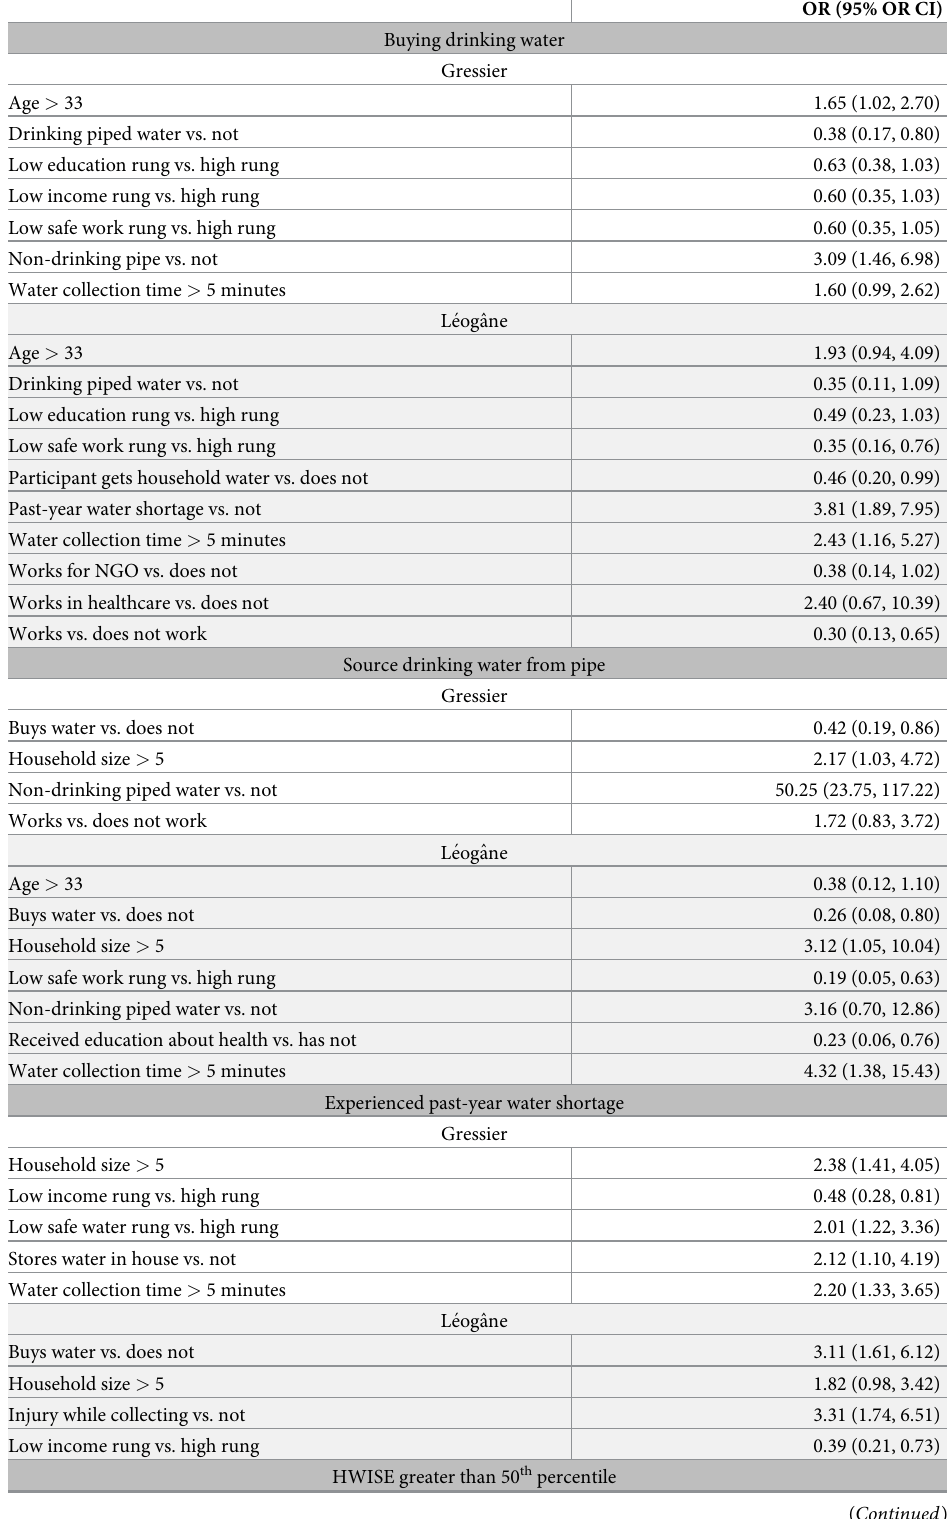
Table 4. Factors associated with key water-related